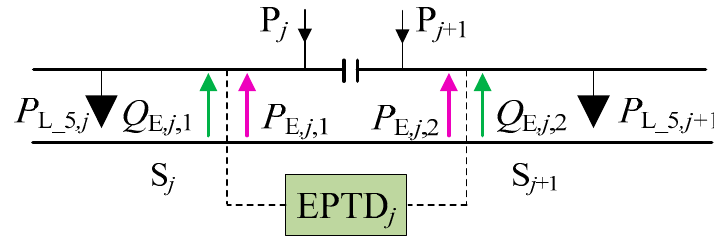
Figure 7. Control block diagram of EPTD improving power quality.